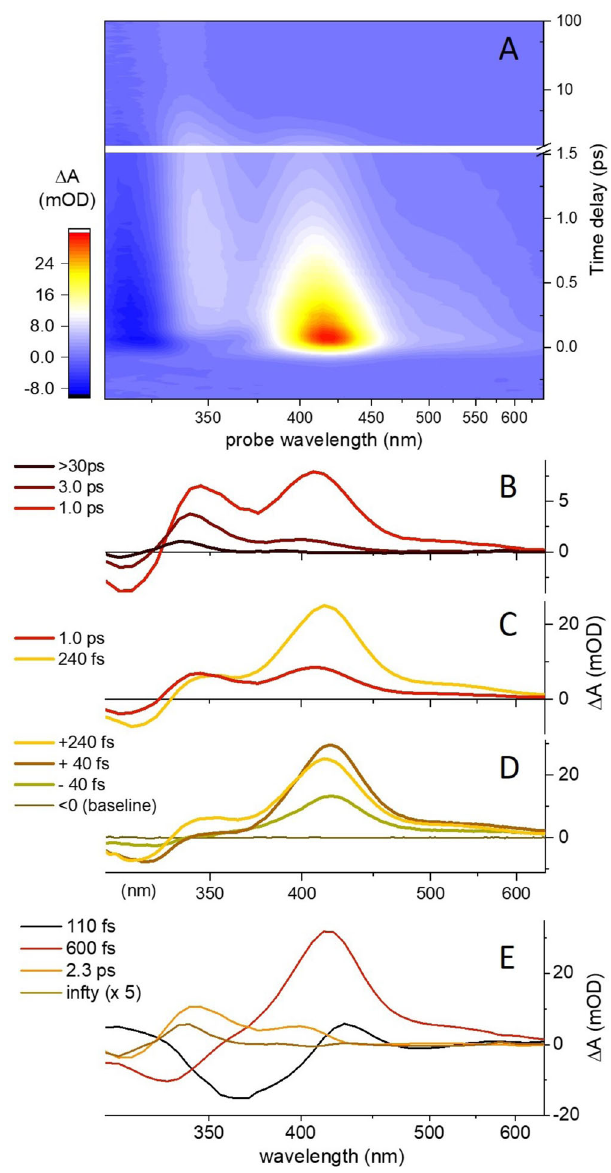
Fig. 6 | Transient absorption (TA) spectroscopy of a methanol solution of MTDP upon 290nm light excitation. A False-color representation of the pump- induced absorption change ( Δ A, in mOD) as a function of probe wavelength (nm) and pump-probe delay (in ps). A selection of TA spectra( Δ A) at late, intermediate, and early pump-probe time delays is displayed in B – D , respectively. E Decay- Associated Spectra (DAS) obtained from the global fi t of the entire TA dataset displayed in A by a multiexponential kinetics involving 4 time constants (see also Supplementary Fig. 31). Source data are provided as a Source Data fi